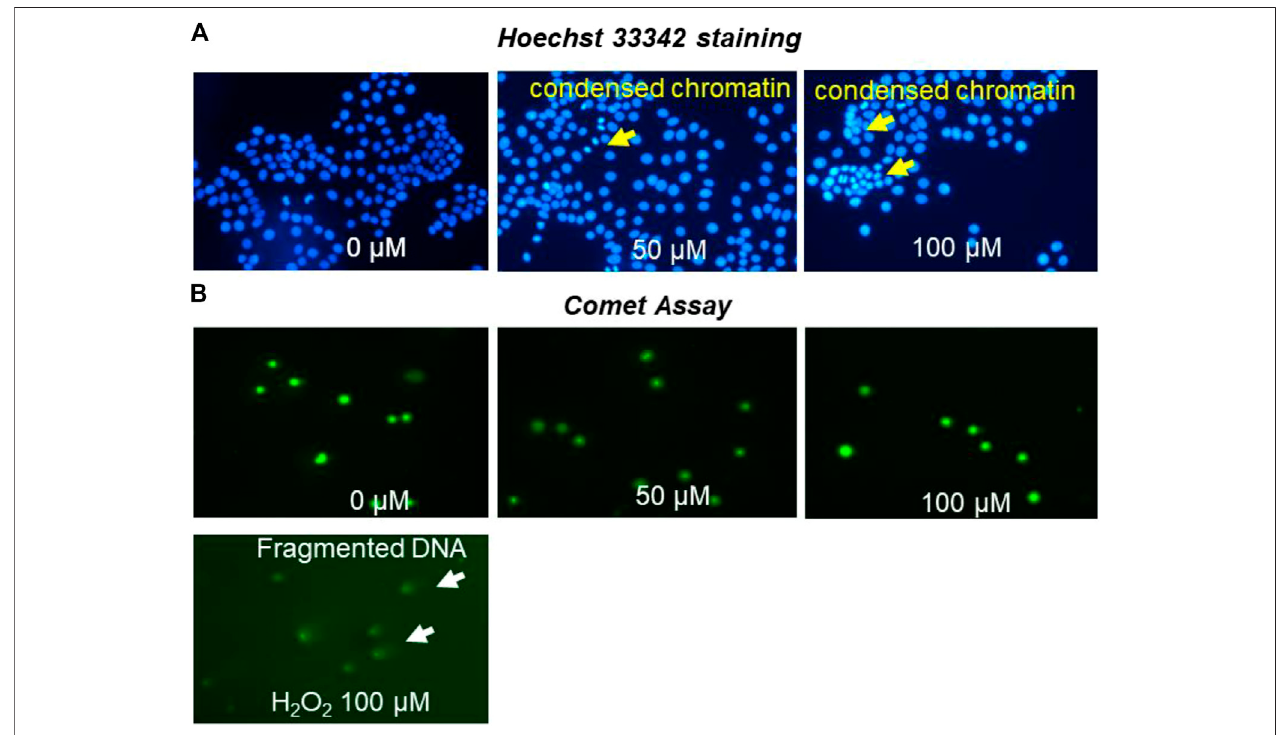
FIGURE 9 | MCF-7 nuclei staining by Hoechst 33,342 (A) photomicrographs of stained DNA of MCF-7 cells (alkaline comet assay) (B) apoptosis detection following treatment with different concentrations of OXY for 24 h and 100 µM H 2 O 2 for 4 h.